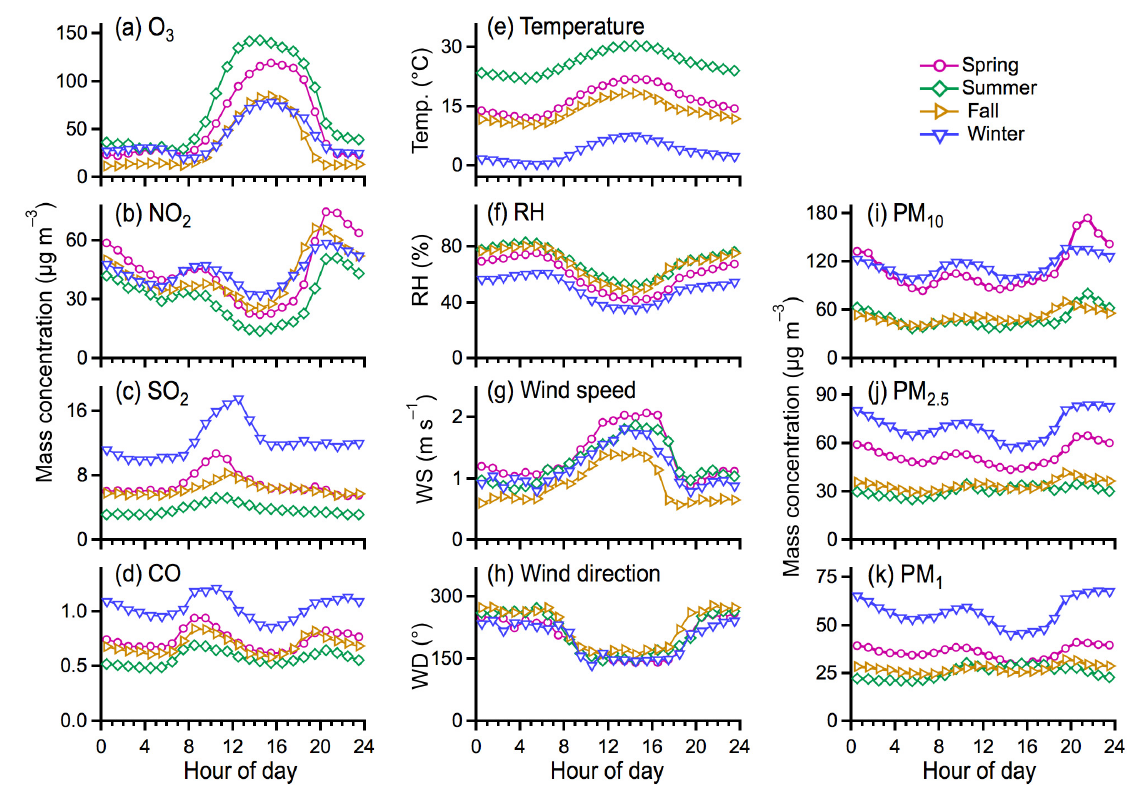
Figure 6. Diurnal profiles of ( a – d ) the precursor gaseous pollutants of O 3 , NO 2 , SO 2 , and CO and ( e – h ) the meteorological parameters of temperature, relative humidity, wind speed, and wind direction, and ( i – k ) the mass concentrations of PM 10 , PM 2.5 , and PM 1 for spring, summer, fall, and winter seasons.